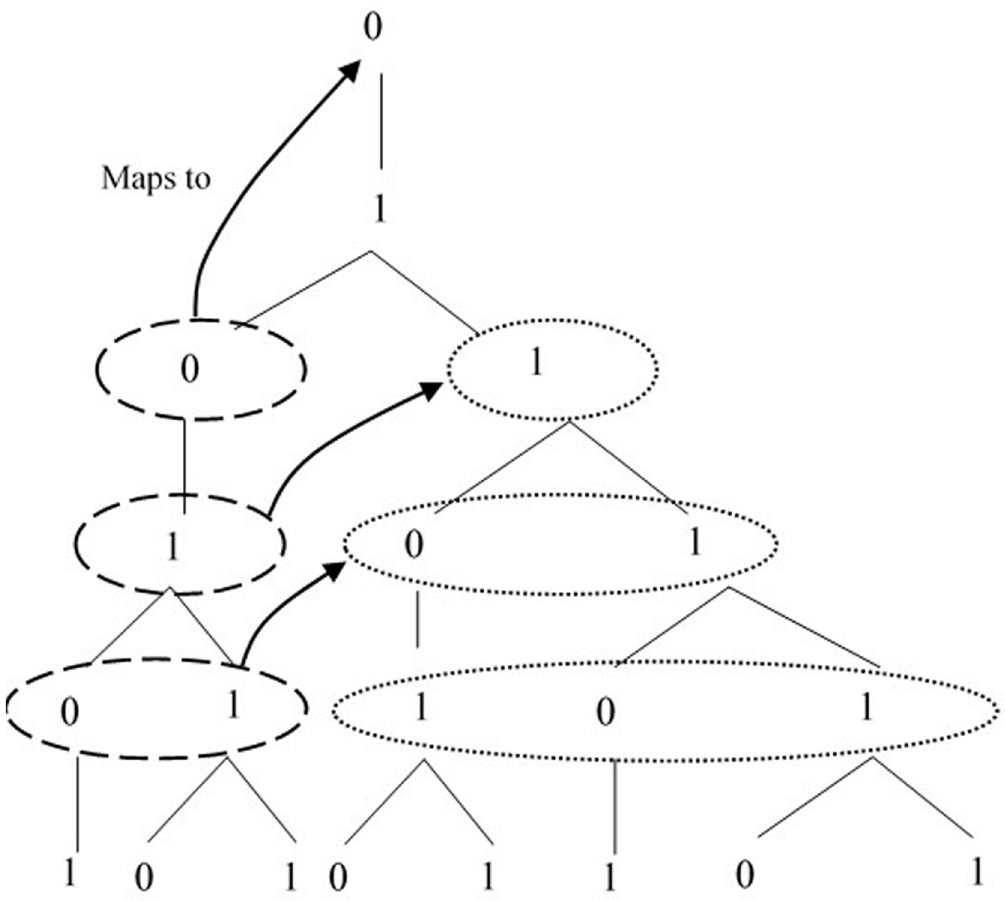
Fig 2. Representation of